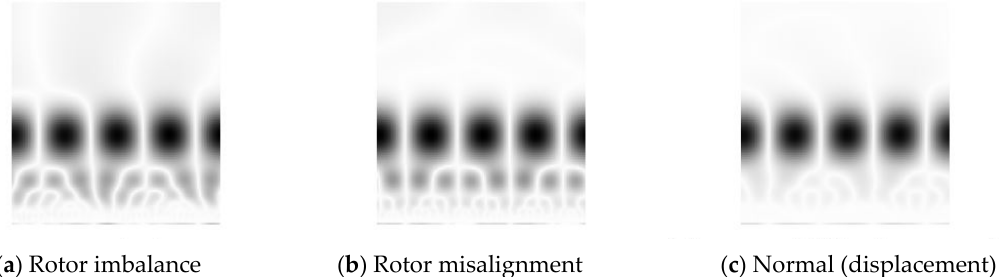
Figure 8. Preprocessed CWTSs of the displacement data.